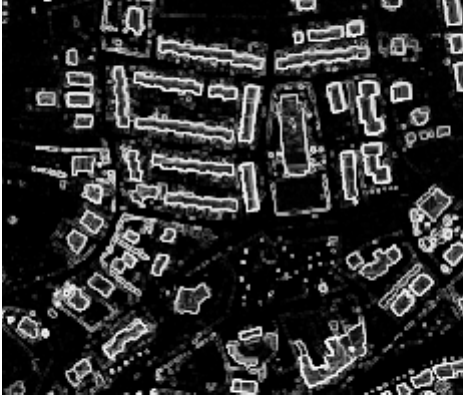
Figure 5. The slope map.